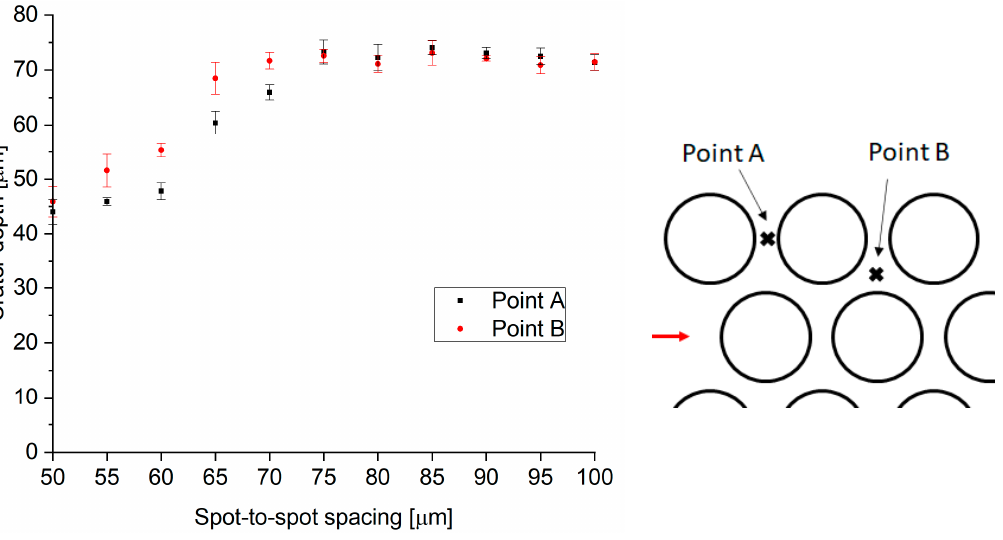
Figure 9. Height of the two key points between adjacent craters. The pulse energy used was 1.46 mJ, with the 200 W SPI laser.